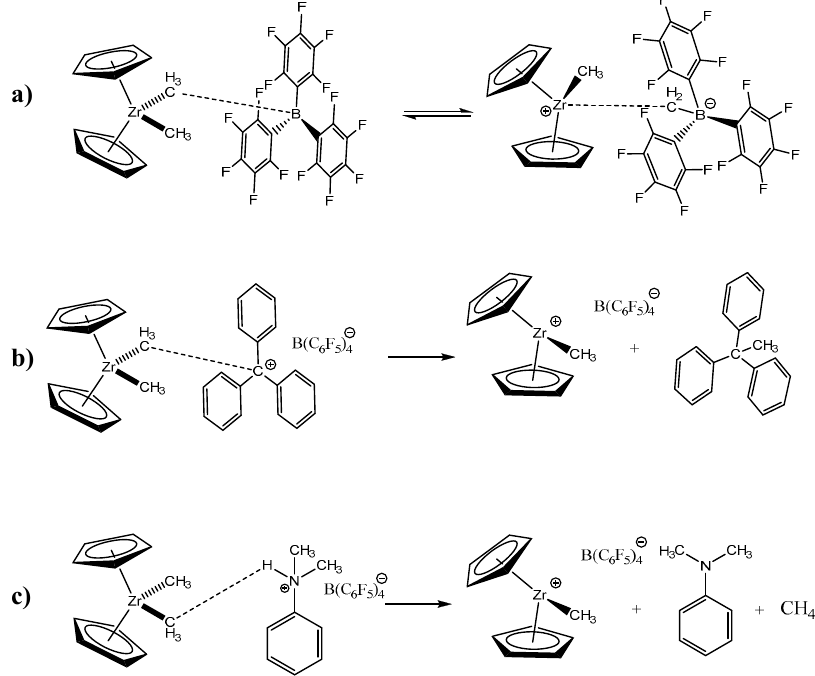
Figure 1. Schematic representation of the activation of a zirconocene catalyst (CP 2 ZrCl 2 ) by ( a ) [B(C 6 F 5 ) 3 ], ( b ) [(C 6 H 5 ) 3 C] + [B(C 6 F 5 ) 4 ] − and ( c ) [C 6 H 5 NHMe 2 ] + [B(C 6 F 5 ) 4 ] −